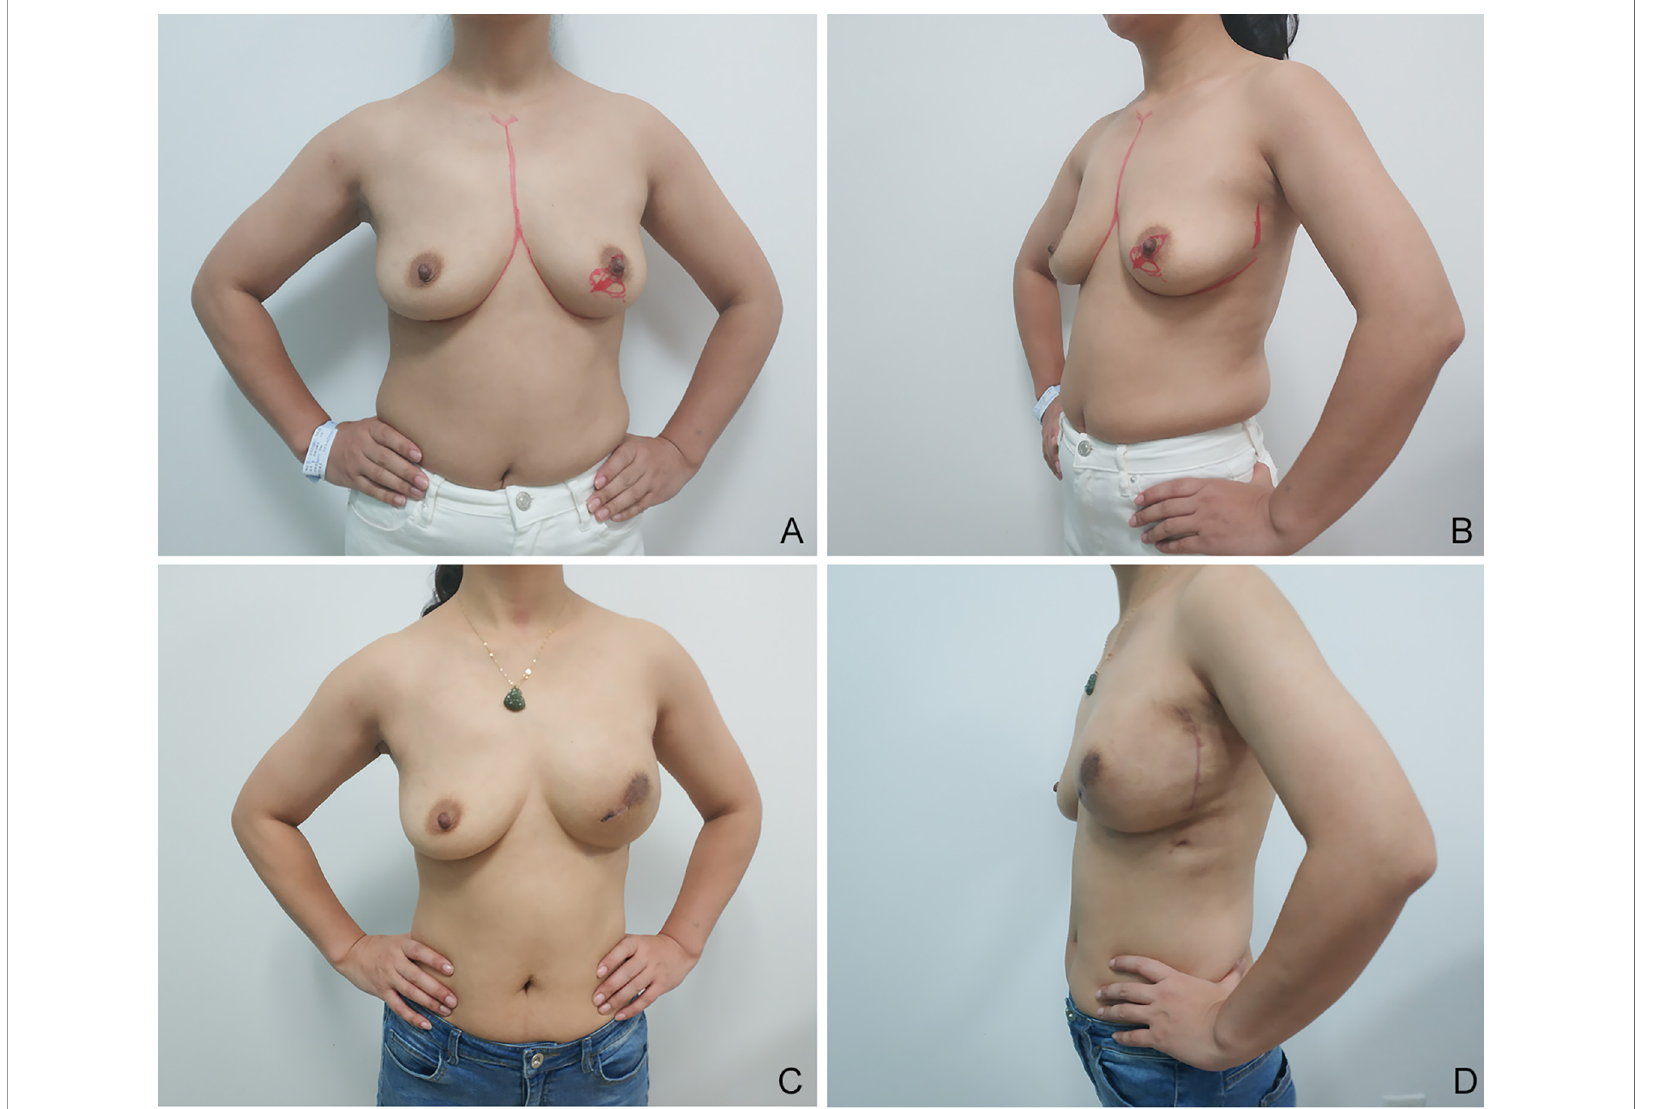
FIGURE 1 | Images of a 30-year-old patient, which were obtained 1 year after left breast nipple-sparing mastectomy with a 280-cm 3 Sumei high-pro fi le implant and partial latissimus dorsi muscle fl ap (MIPLD) for breast reconstruction. Note the adequate coverage of implant and acceptable inframammary fold. Appropriate volume is evident at the superior and inferior poles and laterally. (A) Frontal view before surgery; (B) lateral view before surgery; (C) frontal view after surgery; and (D) lateral view after